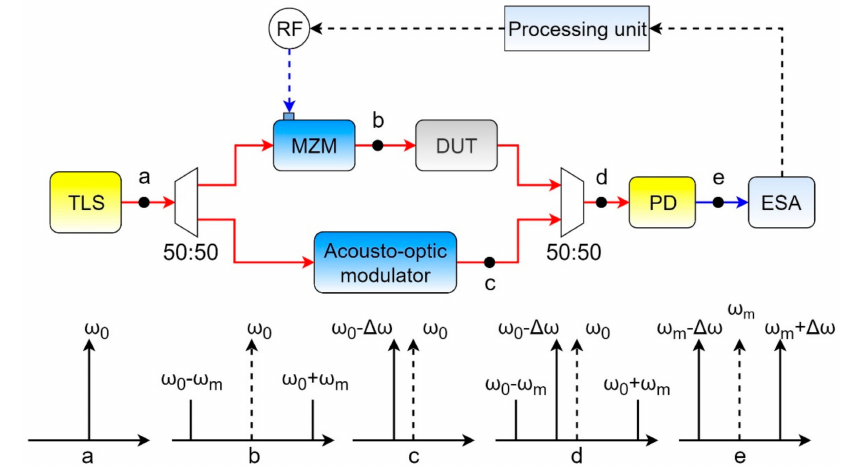
Figure 8. The schematic diagram of the OVA based on asymmetric ODSB: TLS—tunable laser source; MZM—Mach–Zehnder modulator; RF—radio frequency; DUT—device under test; PD—photodetector; ESA—electrical spectrum analyzer; red lines—optical signal; blue lines—electrical signal; dotted line—data path; ω 0 —the frequency of the optical carrier; ω m —the modulation frequency; ∆ ω —a fixed frequency shift (adapted from